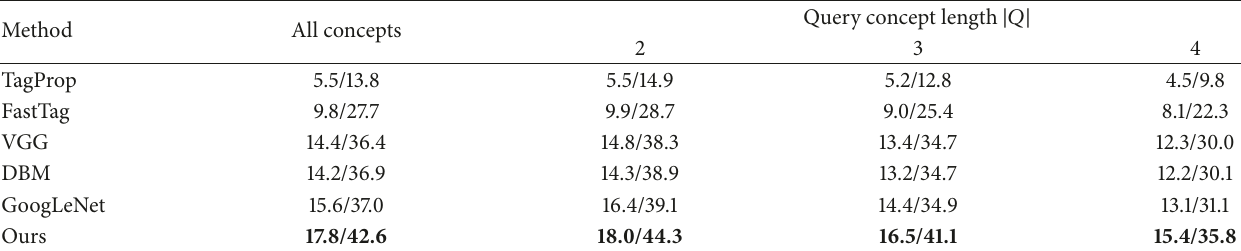
Table 2: MAPs (%) and P@10s (%) of semantic image retrieval over all 1581 semantic queries on NUS-WIDE. MAP scores and P@10 scores are given in the format